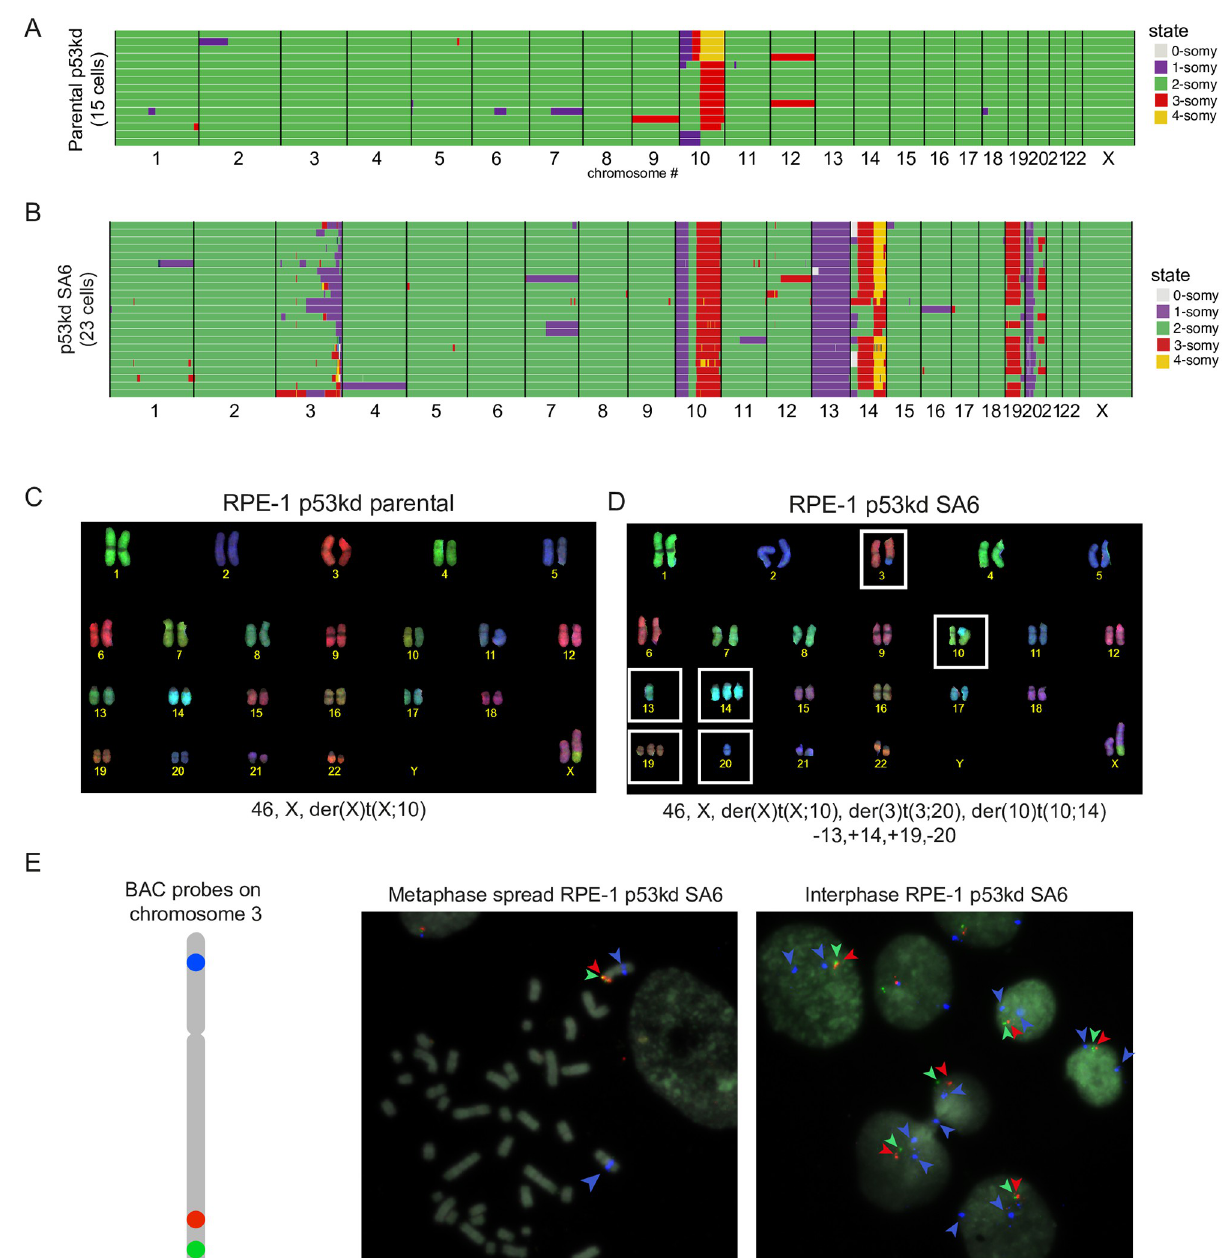
Fig 5. Segmental aneuploidies can lead to the onset of BFB-cycles via dicentric chromosome formation. A. Genome-wide chromosome copy number profiles of parental RPE-1 p53kd as determined by single-cell sequencing. Green indicates disomic chromosome regions, purple monosomic, red trisomic and yellow tetrasomic. Gain of the q-arm of chromosome 10 and occasional gain of chromosome 12 is expected. B. Genome-wide chromosome copy number profiles of clone SA6 as determined by single-cell sequencing as in A. Different patterns of aneuploidy are seen in chromosome 3. C-D. Representative images of chromosome spreads labeled with combined binary ratio labelling–fluorescence in situ hybridization of parental RPE-1 cells and clone SA6. The corresponding karyotypes are indicated below the images. White boxes indicate both numerical and segmental abnormalities specific to SA6. E) Metaphase (left) and interphase (right) representative images of cells from clone SA6, using BAC probes specific for different locations throughout the long arm (in red and green) and the short arm (in